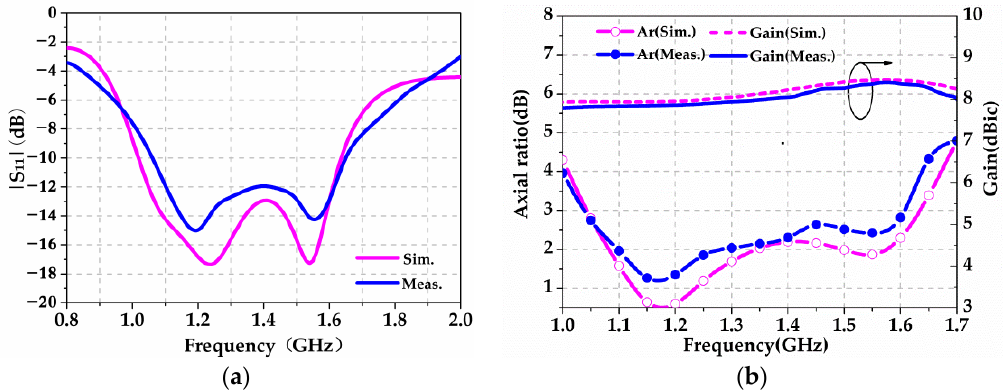
Figure 6. Simulation and measurement results for State-I: ( a ) | S 11 |; ( b ) AR and gain. Electronics 2020 , 9 , 873